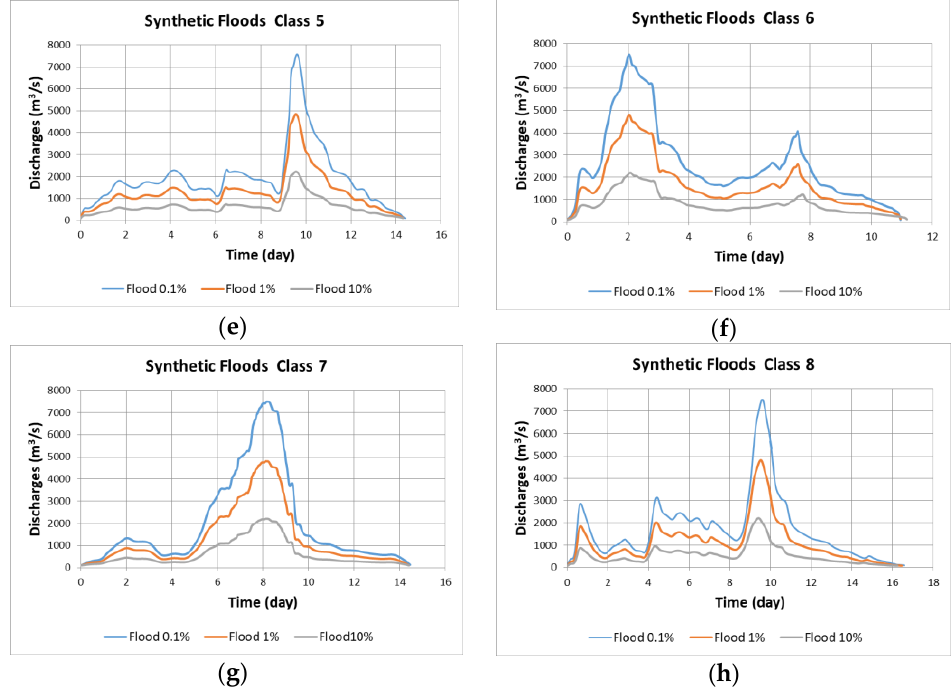
Figure 7. Ensemble of the design flood hydrographs: ( a ) DF Class 1; ( b ) DF Class 2; ( c ) DF Class 3; ( d ) DF Class 4; ( e ) DF Class 5; ( f ) DF Class 6; ( g ) DF Class 7; ( h ) DF Class 8;